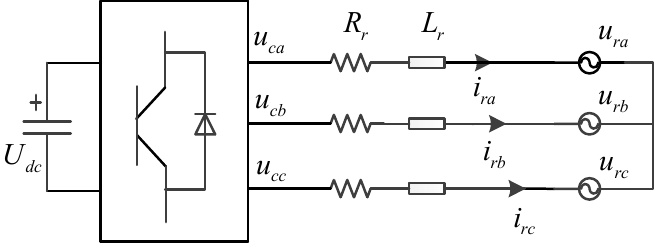
Figure 4. The structure diagram of the RSC main circuit.